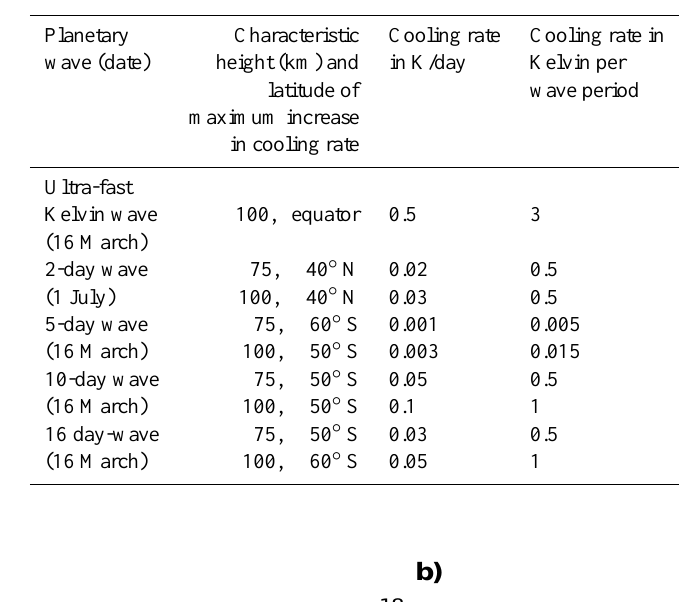
Table 1. Maximum order-of-magnitude of incrasing the CO 2 15- µ m band cooling rate in the upper mesosphere and lower thermosphere due to the temperature perturbations caused by a planetary wave.